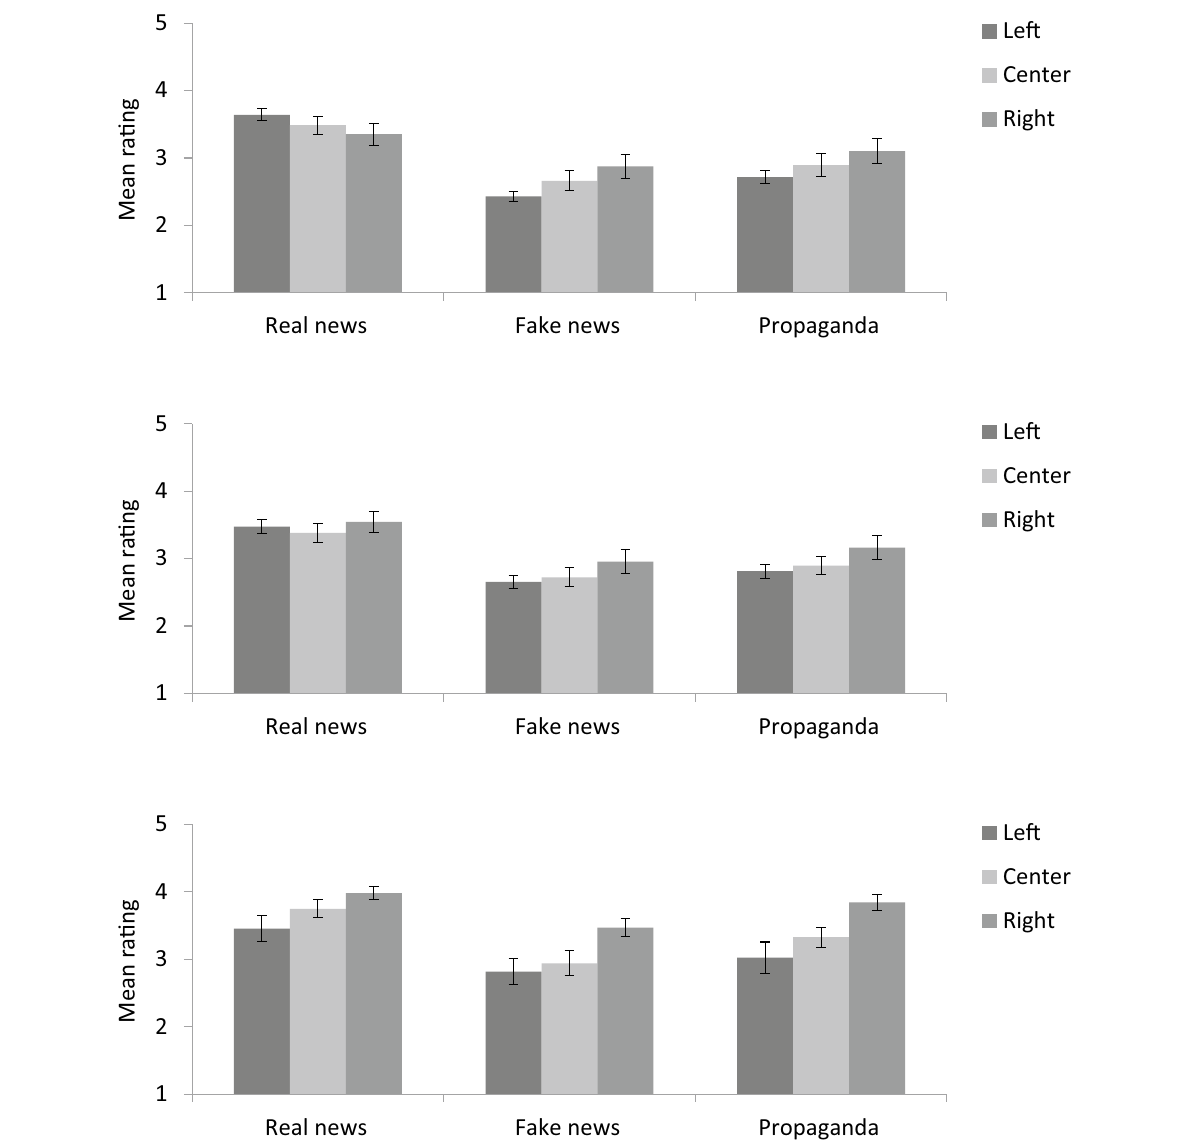
Fig. 2 Average Real news, Fake news, and Propaganda ratings—split by Political identification. Top panel: 2017 data. Middle panel: 2018 data. Bottom panel: 2020 data. Error bars represent 95% confidence intervals of cell